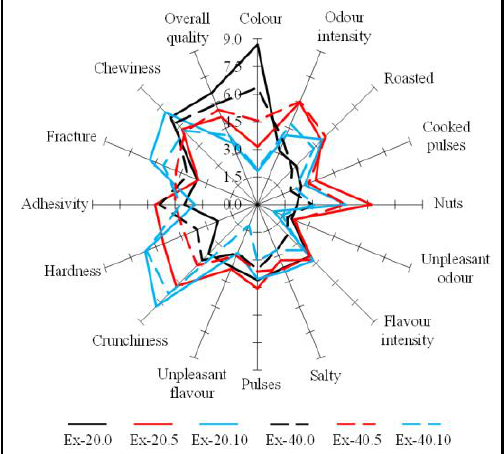
Figure 1. Sensory analysis of the six different extrudates formulated with different proportions of rice, bean, and carob fruit flours. Sample code: Ex-20.0 (20% bean; 0% whole carob fruit); Ex-20.5 (20% bean; 5% whole carob fruit); Ex-20.10 (20% bean; 10% whole carob fruit); Ex-40.0 (40% bean; 0% whole carob fruit); Ex-40.5 (40% bean; 5% whole carob fruit); and Ex-40.10 (40% bean; 10% whole carob fruit).